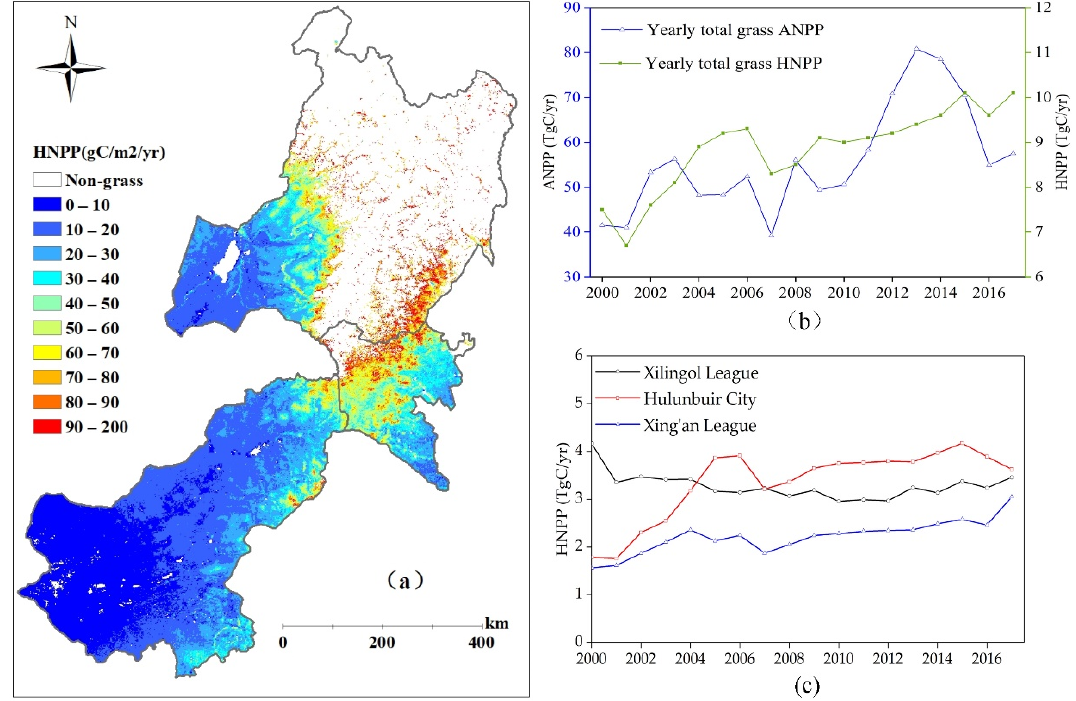
Figure 6. Spatial distribution of calculated averaged HNPP ( a ), variation of total grasslands ANPP and HNPP ( b ), and variation of total grasslands HNPP in Xilingol League, Hulunbuir City, and Xing’an League ( c ) over the period of 2000 to 2017 in eastern Inner Mongolia.